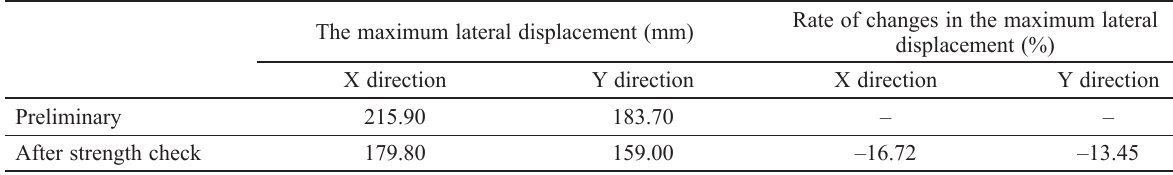
Table 2. Changes in the lateral displacements at the top in the X and Y directions